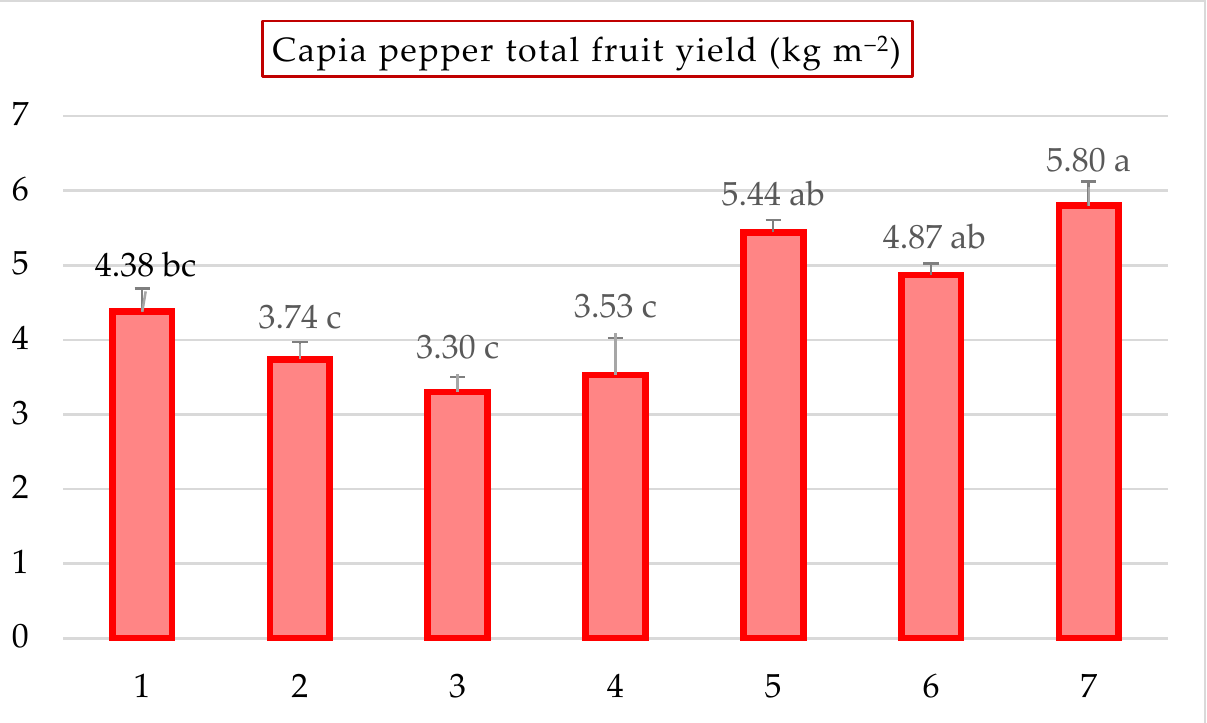
Figure 3. Effects of the bio-fertilizers on total fruit yield of soilless-grown capia pepper under reduced mineral fertilizers in the Mediterranean climate in spring greenhouse conditions. 1:100% MF, 2:60% MF + PGPR, 3:60% MF + AMF, 4:60% MF + PGPR + AMF, 5:80% MF + PGPR, 6:80% MF + AMF, 7:80% MF + PGPR + AMF. MF: mineral fertilizer; PGPR: plant-growth-promoting rhizobacteria; AMF: arbuscular mycor- rhizal fungi. Different letters within a column indicate significant differences, LSD 0 . 05 : 1.134, p : 0.0023.